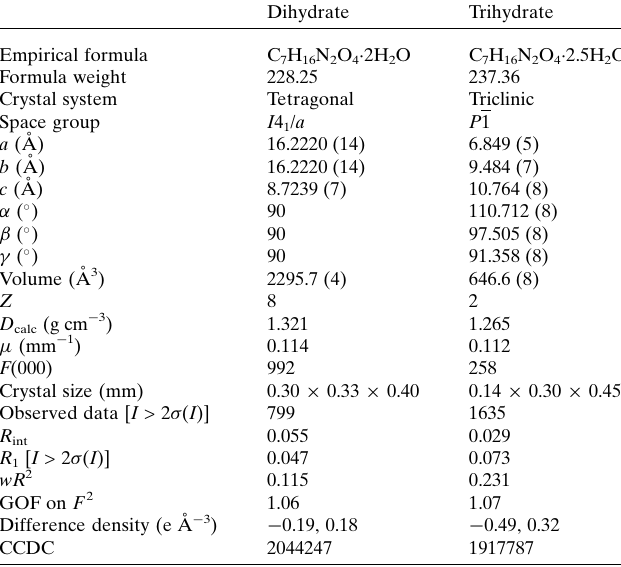
Table 1 Detailed crystallographic data for the PDA-OXA dihydrate and trihydrate.